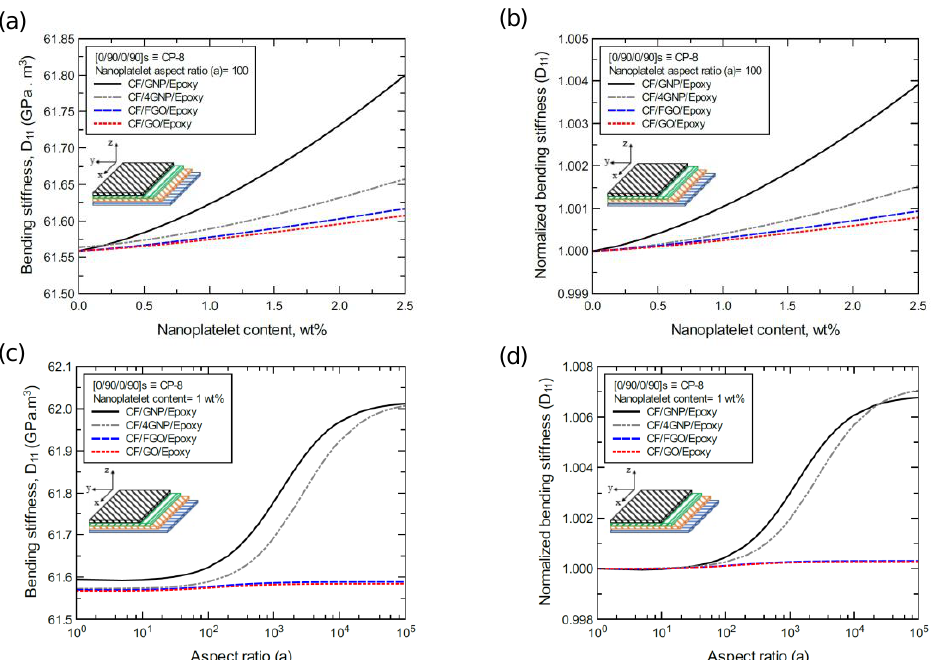
Figure 15. Comparison of the predicted bending stiffness (D 11 ) for a [0/90/0/90]s (CP-8)-laminated composite plate based on the nanoplatelet type, content, and aspect ratio; ( a ) predicted D 11 for various nanoplatelet contents at 100 aspect ratio, and the normalized response is shown in ( b ); ( c ) predicted D 11 for various aspect ratio values at 1.0 wt% nanoplatelet content, and the normalized response is shown in ( d ). The volume fraction of CF is 56%.